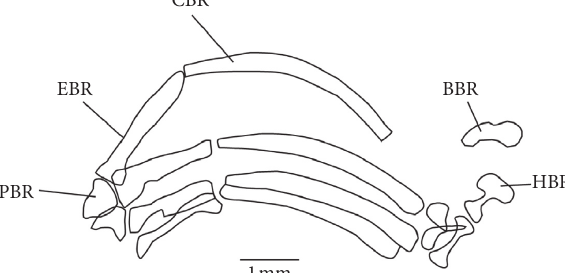
Figure 3: Branchial apparatus of G. rossica . BBR: basibranchial; CBR: ceratobranchial; EBR: epibranchial; HBR: hypobranchial; PBR: